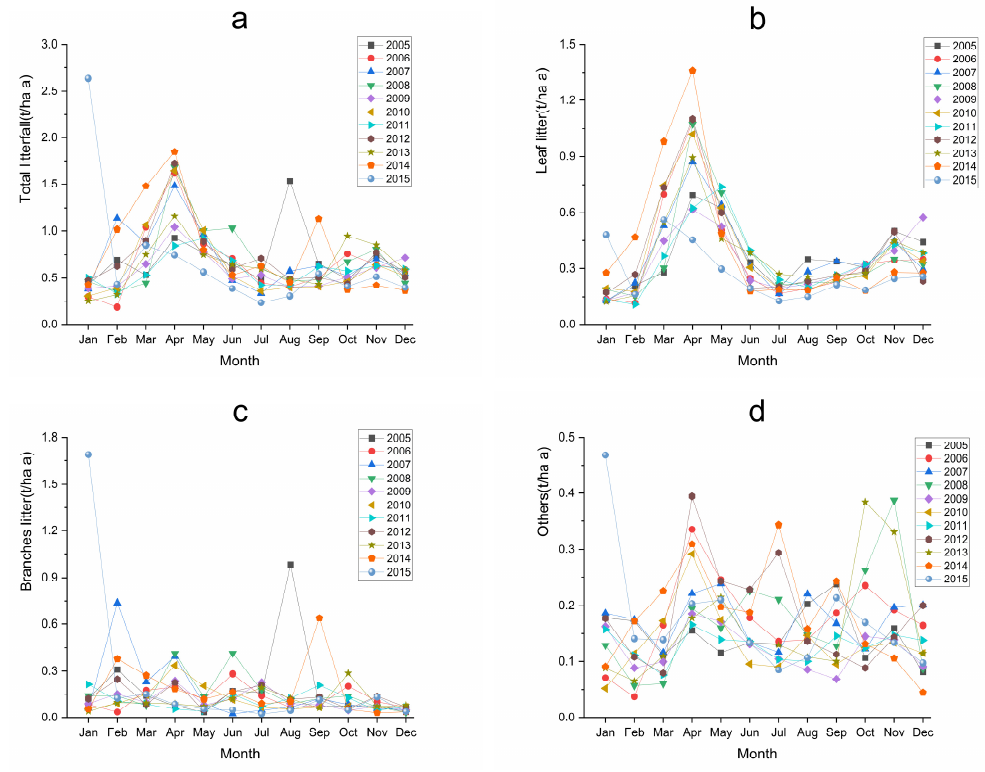
Figure 2. Monthly variation of litterfall and its component output in evergreen broadleaf forest in Ailao Mountain. ( a ) Total litterfall, ( b ) Leaf litter, ( c ) Branches litter, ( d ) Others. Table 2. Intra ‐ year variation of litterfall productions and components.